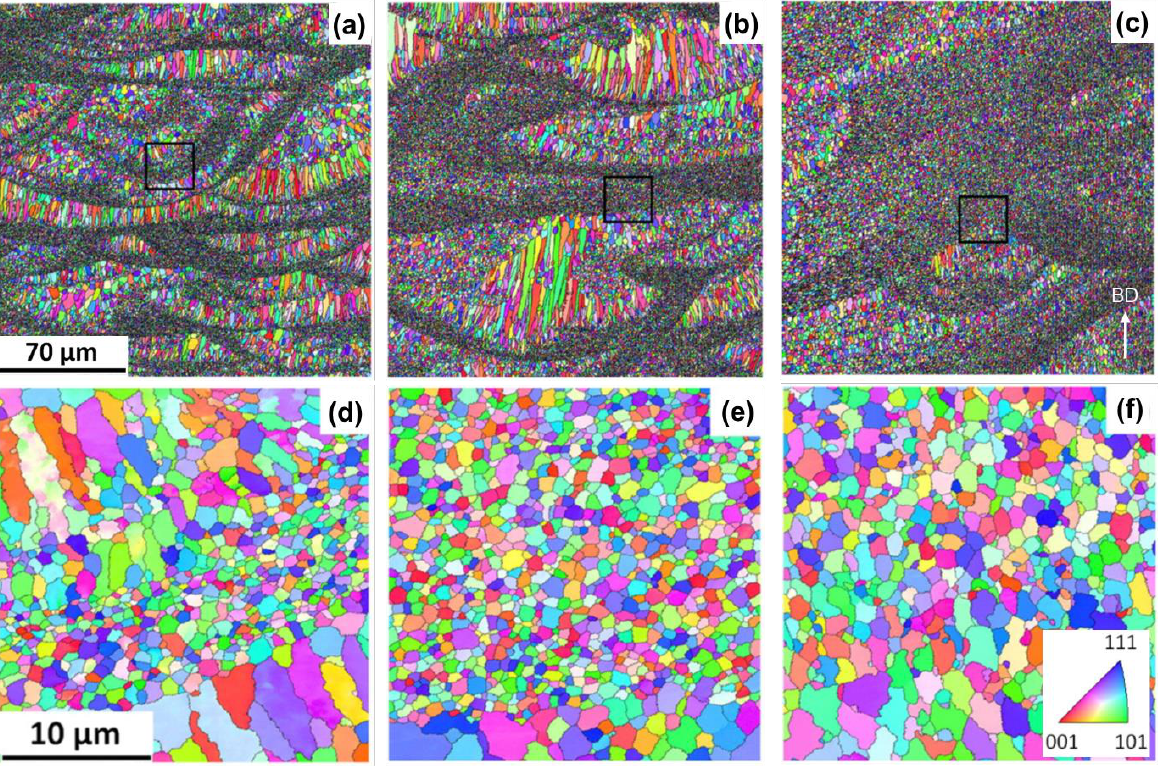
Figure 11. EBSD microstructures for an Al–Mg–Sc–Zr alloy manufactured under ( a , d ) scanning speed of 1600 mm/s and platform temperature of 308 K, ( b , e ) scanning speed of 800 mm/s and platform temperature of 308 K, and ( c , f ) scanning speed of 800 mm/s and platform temperature of 473 K. ( d – f ) High magnification of the areas highlighted in ( a – c ). Reprinted with permission from ref. [13], copyright 2021 Elsevier.